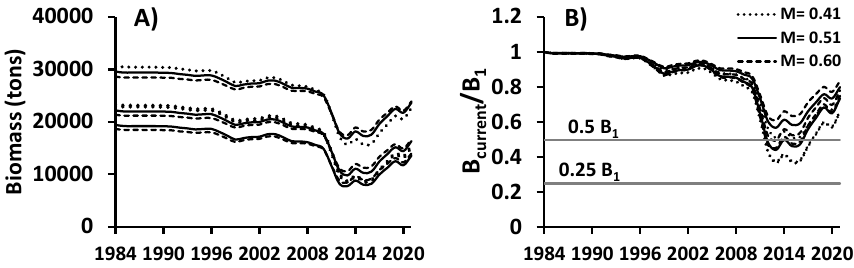
Figure 3. Biomass from stock reduction analysis solution for Micropogonias megalops in the upper Gulf of California. For each type of line, the upper line is the SRA solution restricted by B 2011 = 21,361 t, the middle line is the SRA solution restricted by B 2011 = 14,412 t, and the lower line is the SRA minimum acceptable solution. ( A ) estimated biomass; ( B ) estimated biomass ratio of current versus B 1 .